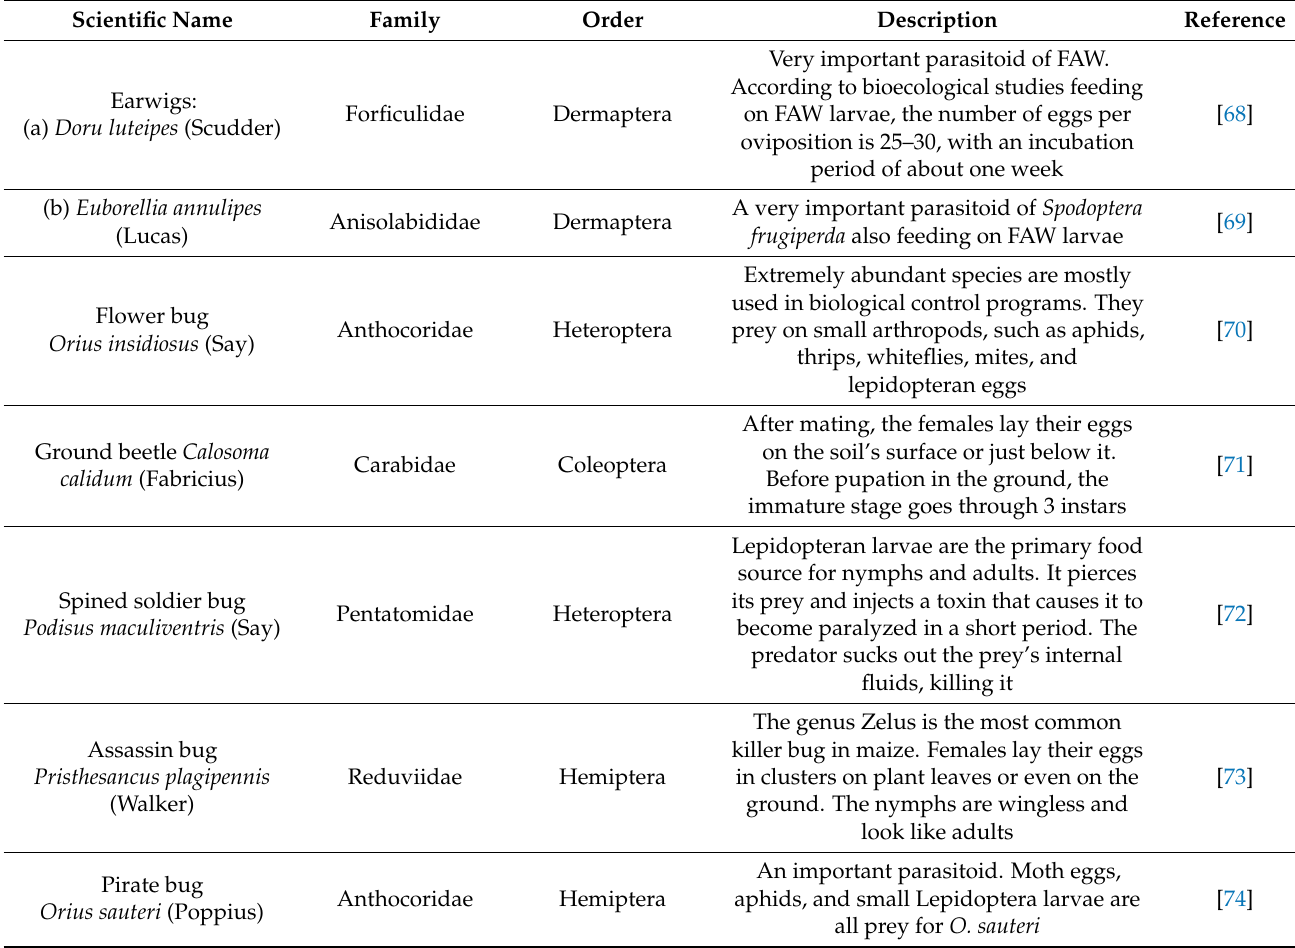
Table 1. Predators against Spodoptera frugiperda